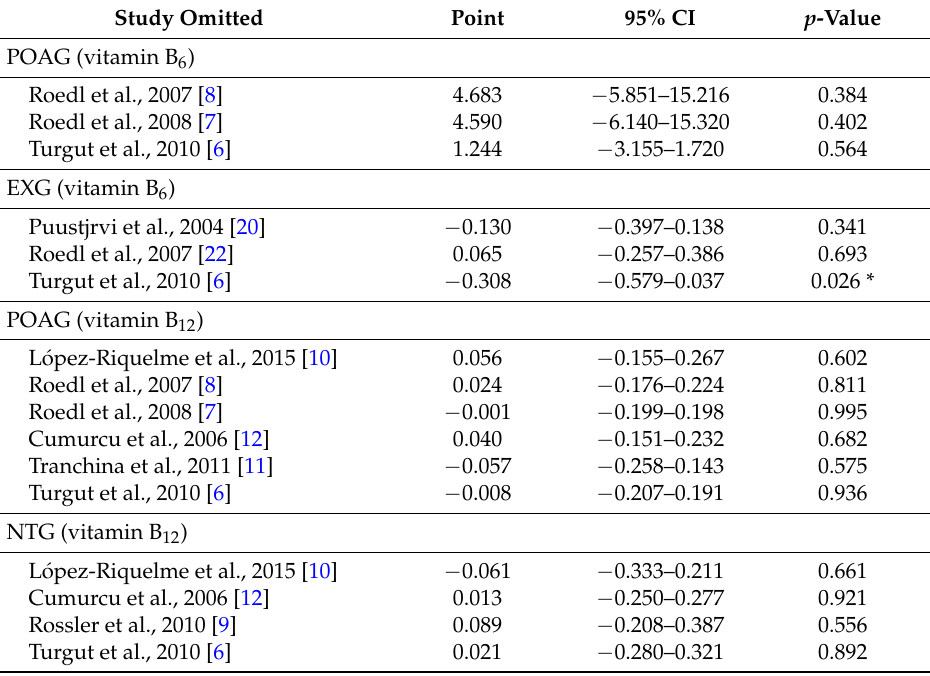
Figure 5. Funnel plot analysis to detect publication bias, vitamin B 6 in POAG ( A ), vitamin B 6 in EXG ( B ), vitamin B 12 in POAG ( C ), vitamin B 12 in NTG ( D ), vitamin B 12 in EXG ( E ), and vitamin D in POAG ( F ).